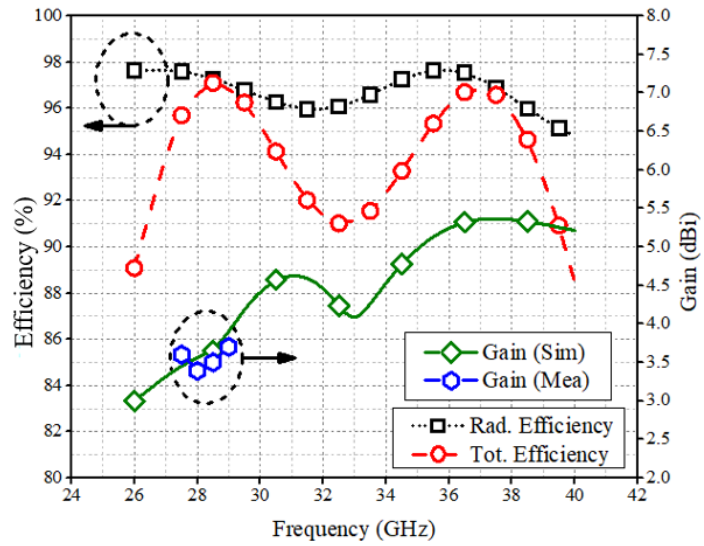
Figure 4. Single element gain and efficiency .